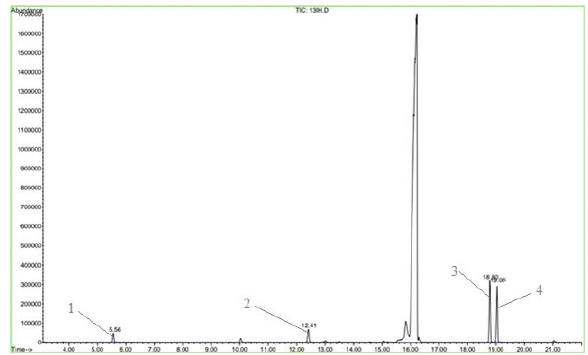
Figure 7. Chromatogram of carbohydrates formed as a result of enzymatic hydrolysis in the herbal mixture No. 13 (1 – arabi- nose, internal standard; 2 – glucose; 3–4 – fructose).